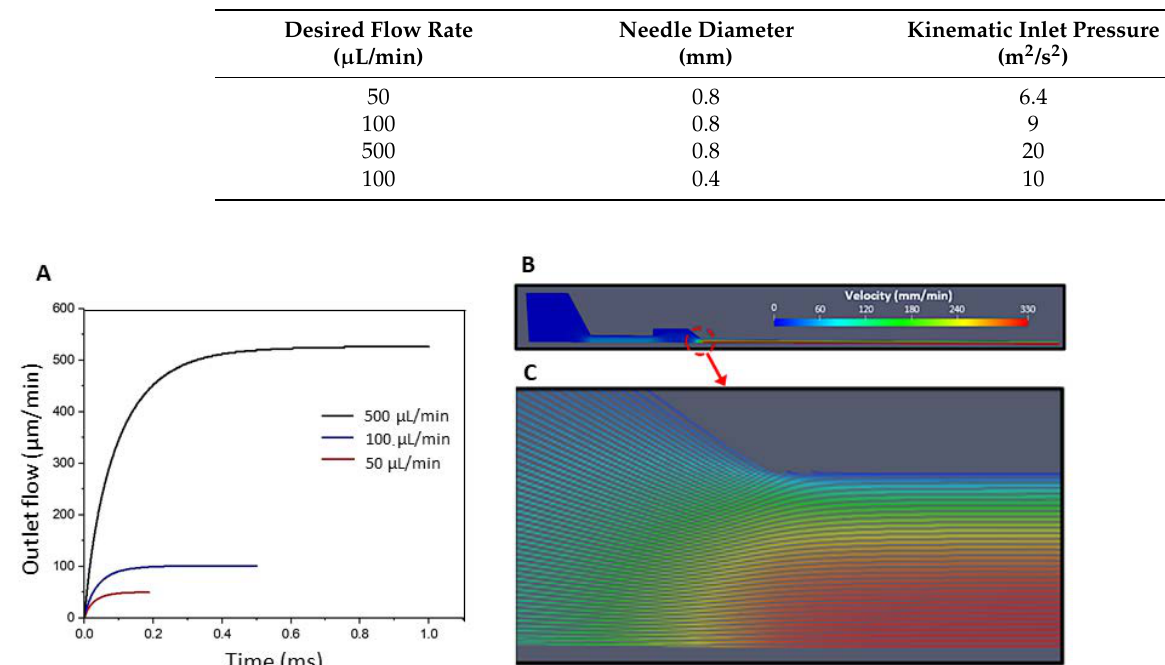
Figure 8. ( A ) Outflow rates for kinematic inlet pressures 6.4, 9, and 20 m 2 /s 2 led to steady state flow rates of 50, 100, and 500 µL/min, respectively. ( B , C ) Variation of the velocity magnitude along the geometry. ( B ) Velocity profile for a feed rate of 100 µL/min and needle size 0.8 mm. ( C )